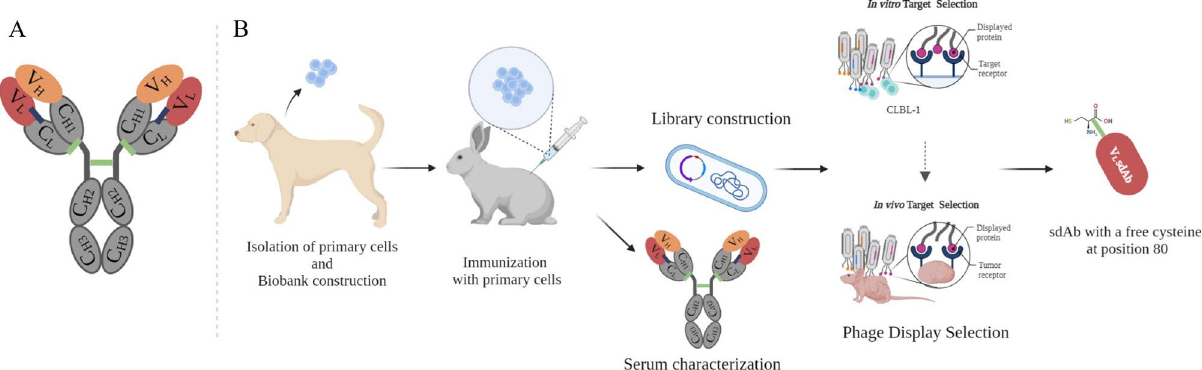
Figure 1. Schematic illustration of the adopted strategy for the development of rabbit derived sdAb ADC. ( A ) Representation of a rabbit IgG antibody. In the present study, we aimed to explore the potential of rabbit-derived VL-sdAbs to develop a new generation of ADCs. Rabbit IgG contains two identical light chains paired with two identical heavy chains. The light chain is composed of an N-terminal variable domain (VL) (red), followed by one constant domain (C L ). The heavy chain consists of an N-terminal variable domain (V H ) (orange), followed by three constant domains (C H1 , C H2 and C H3 ). C H1 and C H2 are linked via a flexible hinge region and contains three disulfide-bridges (green). Most rabbit kappa light chains of the K1 isotype have an unusual disulfide bridge (blue) that joins the variable and constant domains, usually through cysteine residues at positions 80 and 171. This disulfide bridge links framework region 3 of the variable kappa light chain domain with the constant kappa light chain domain, a linkage not seen in mouse or human antibodies. Thus, when the VL-sdAb is isolated the conserved cysteine at position 80 (Cys80, normally paired with Cys171 in an IgG format) becomes exposed at the protein surface and its sulfhydryl group becomes free to be explored to selectively conjugate a chemical payload, without requiring further genetic engineering manipulation. ( B ) Representation of the antibody selection process. Aiming to develop a new ADC molecule, we firstly immunized one female New Zealand white rabbit with lymph node primary cells derived from a canine multicentric lymphoma biobank previously established 34 . To induce a strong immune response, the rabbit was immunized and boosted with 1 × 10 7 of cNHL of primary cells isolated from the lymph node of ID5 and ID6 patients diagnosed with Diffuse Large B-Cell Lymphoma (DLBCL). Tumor cells isolated from the patients were thawed, washed and resuspended in PBS. Lymph nodes cNHL primary cells were administered subcutaneously at 2–3 weeks for 3 months. Following the rabbit immunization and validation of the immune response, an immune VL-sdAb library was constructed. To select the best antibodies for NHL targeting, sdAb library was used for an in vitro whole cell and in vivo phage display in a xenograft CLBL-1 murine model. After, the phage display, NGS and sanger sequencing analysis a panel of VL-sdAbs were selected. The three most promising VL-sdAbs were characterized by flow cytometry and immunofluorescence microscopy and then the most promising VL sdAb was chosen to be conjugated to the SN-38 using the free exposed